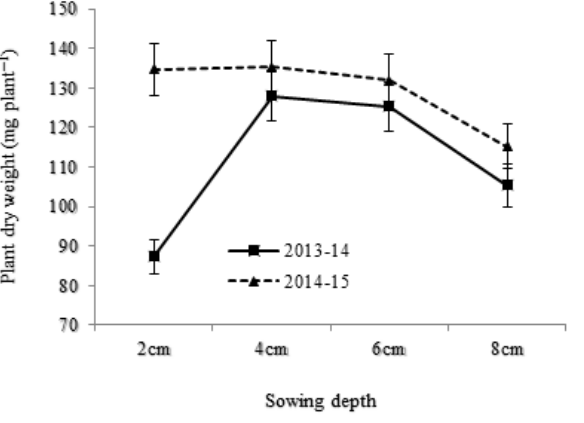
Figure 8: Number of spikes as affected by depth of sowing depth of wheat. Mean (±SD) was calculated from three replicates for each treatment and significantly different at P ≤ 0.05 (LSD test).